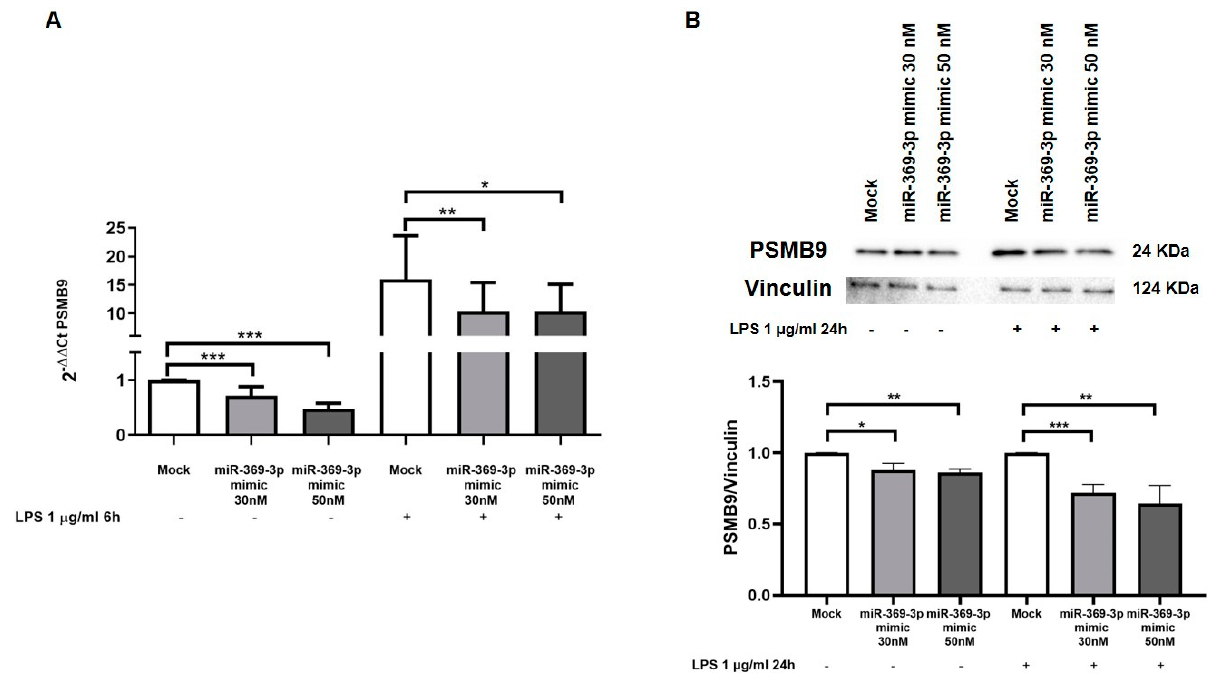
Figure 2. Modulation of PSMB9 mRNA and protein expression by miR-369-3p in RAW264.7 cells. ( A ) The mRNA expression levels of PSMB9 were evaluated by qRT-PCR in RAW264.7 cells transfected with 30 nM and 50 nM of miR-369-3p mimic, both unstimulated and LPS-stimulated. ( B ) Western blot analysis of PSMB9 protein expression after miR-369-3p mimic transfection in the RAW264.7 cell line, both unstimulated and LPS-stimulated. miR-369-3p transfection led to a significant decrease in PSMB9 in LPS-unstimulated as well LPS-stimulated samples. Vinculin was used as housekeeping protein to normalize the data. Data were obtained by comparing normalized sample values to the normalized mock sample value (* p < 0.05; ** p < 0.01; *** p < 0.001).